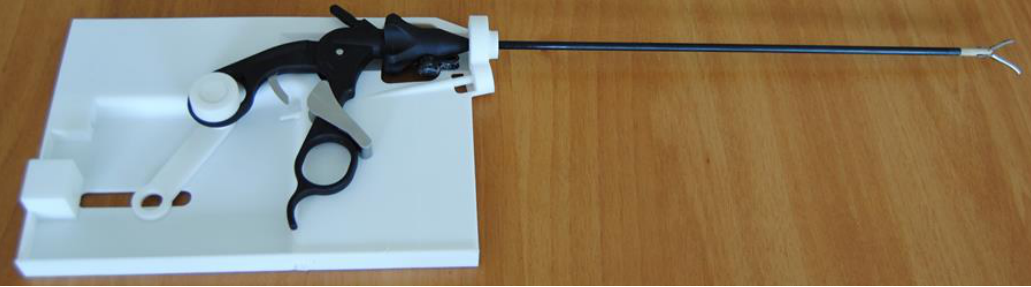
Figure 11. 3D printed adaptor for traditional surgical instruments using this gear pail.